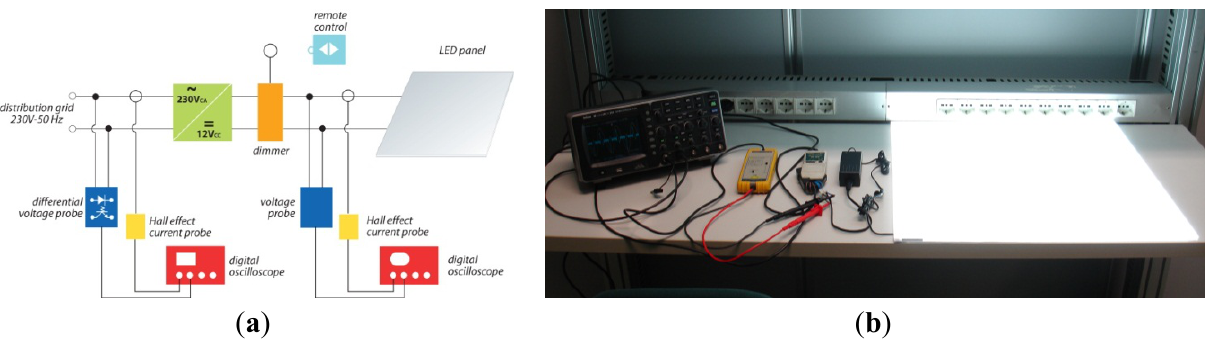
Figure 1. ( a ) Test arrangement for LED panels monitoring survey; ( b ) LED panel during